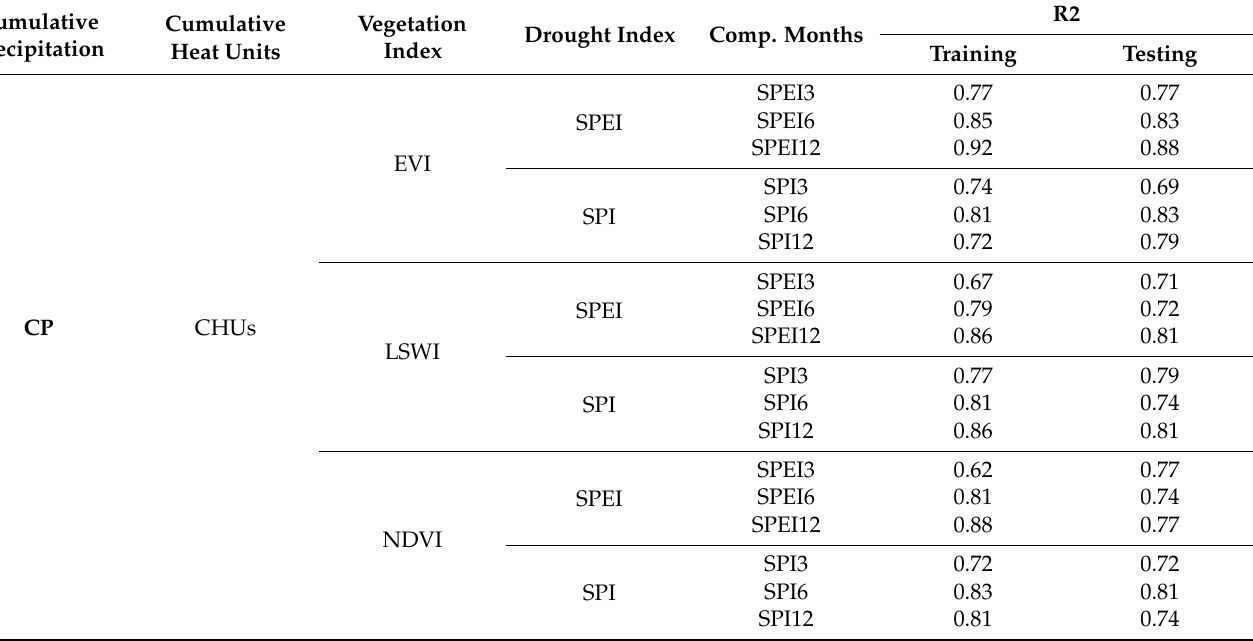
The R 2 training and testing values of ANN results for various combinations of explanatory